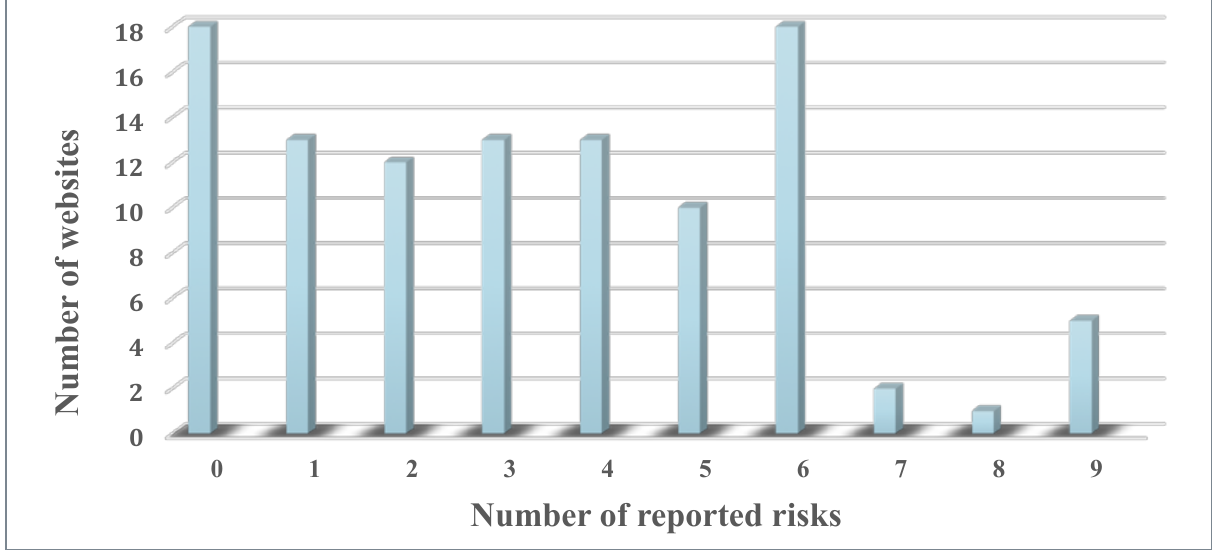
Table II . Number of reported risks per website (N = 105).